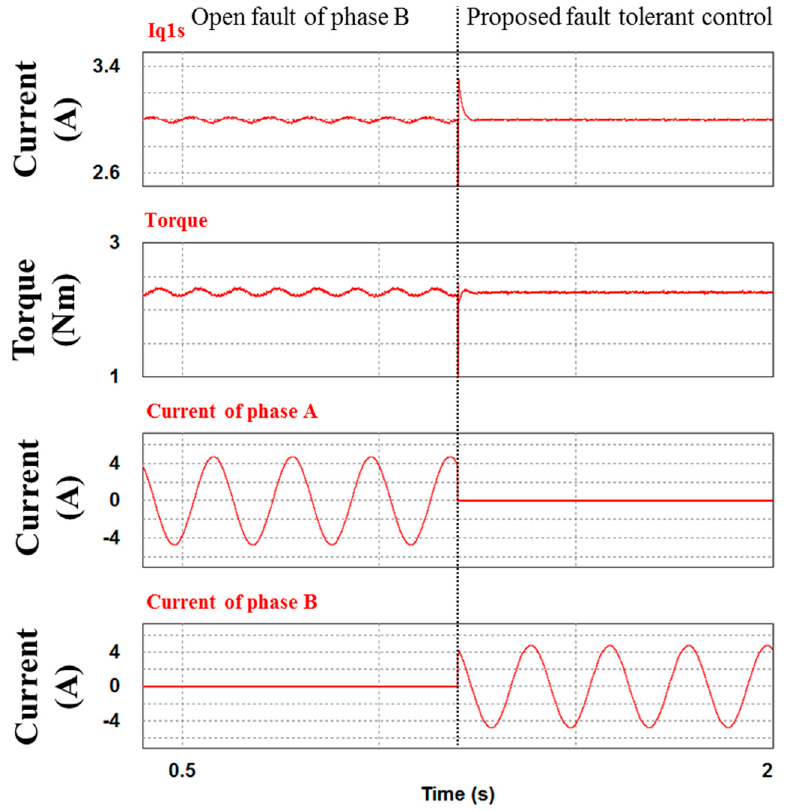
Figure 14. Open fault of Phase B and proposed fault ‐ tolerant control.